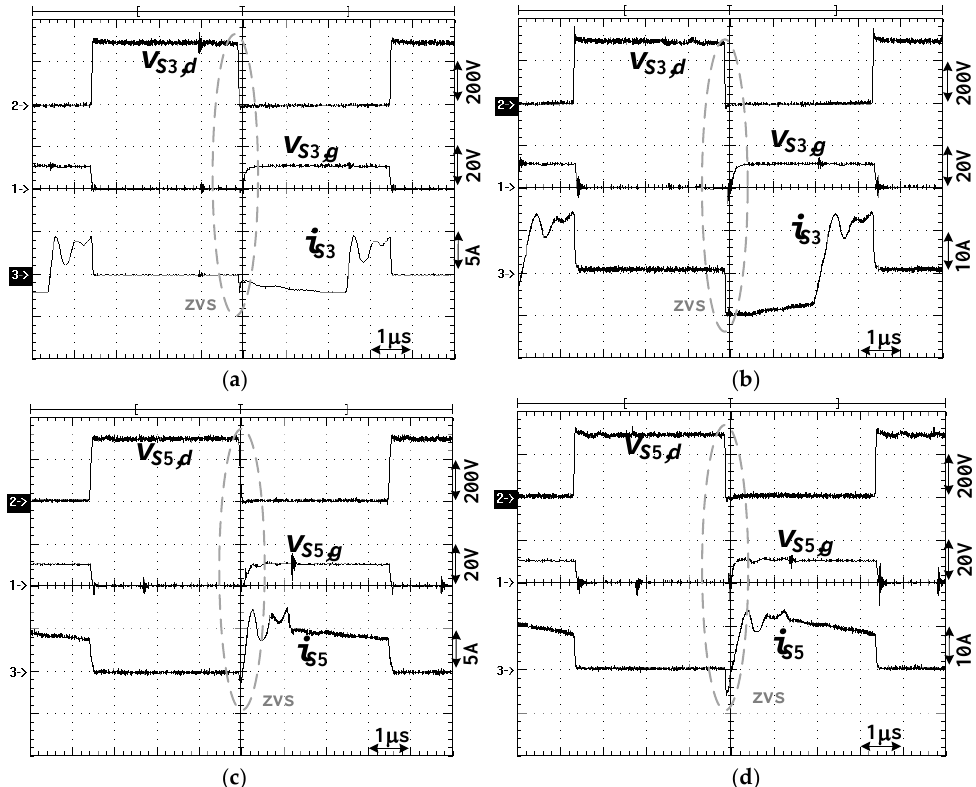
Figure 9. Test waveforms of S 3 and S 5 at V in = 290 V (low voltage input range): ( a ) S 3 under 20% load; ( b ) S 3 under 100% load; ( c ) S 5 under 20% load; ( d ) S 5 under 100% load.